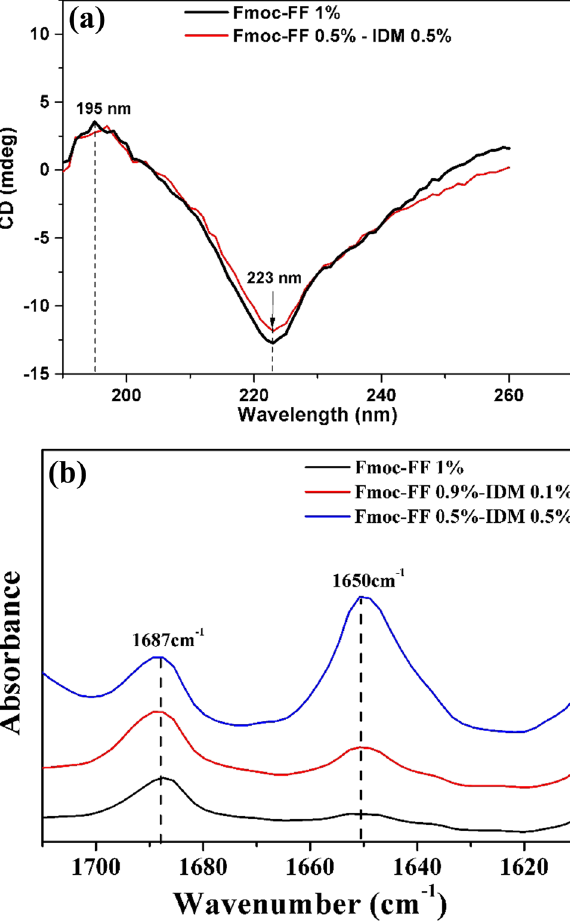
Figure 4: ( a ) CD spectra and ( b ) FTIR spectra of the amide I region, ranging from 1,600 to 1,700 cm − 1 of Fmoc - FF – IDM hydrogels with di ff erent Fmoc - FF/IDM ratio. Curves are vertically o ff set for